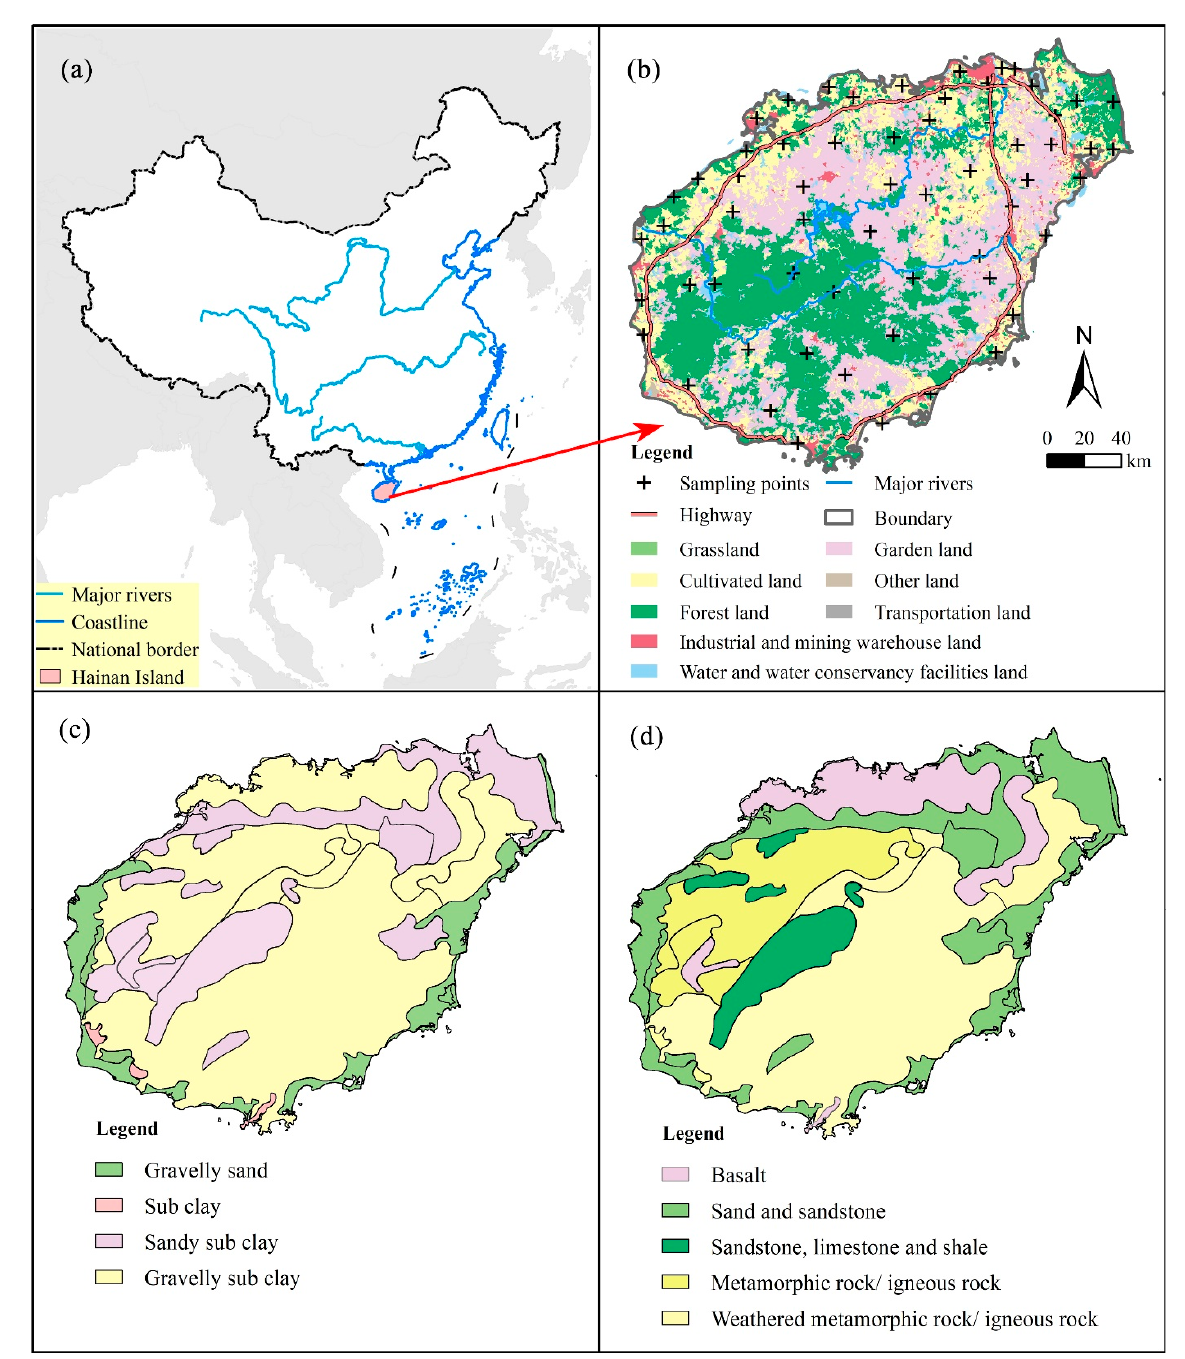
Figure 1. ( a ) The location of the study area in China; ( b ) the sampling sites’ distribution and land use classification; ( c ) the soil media and ( d ) the aquifer media in Hainan Island.